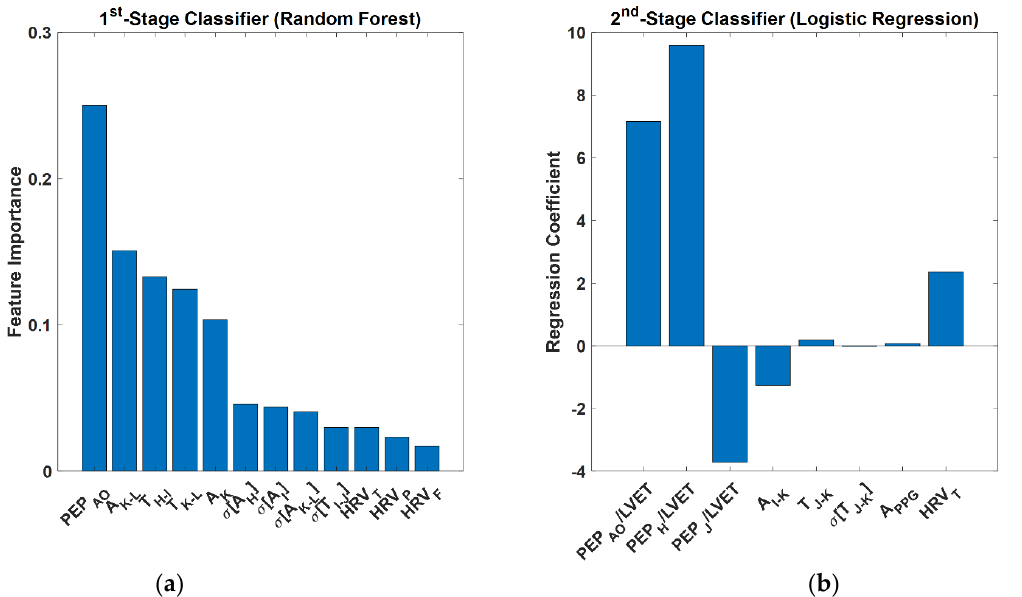
Figure 5. Feature importance associated with the best 1st-stage classifier ( a ) and best 2nd-stage classifier ( b ). Features are all normalized and thus unitless.